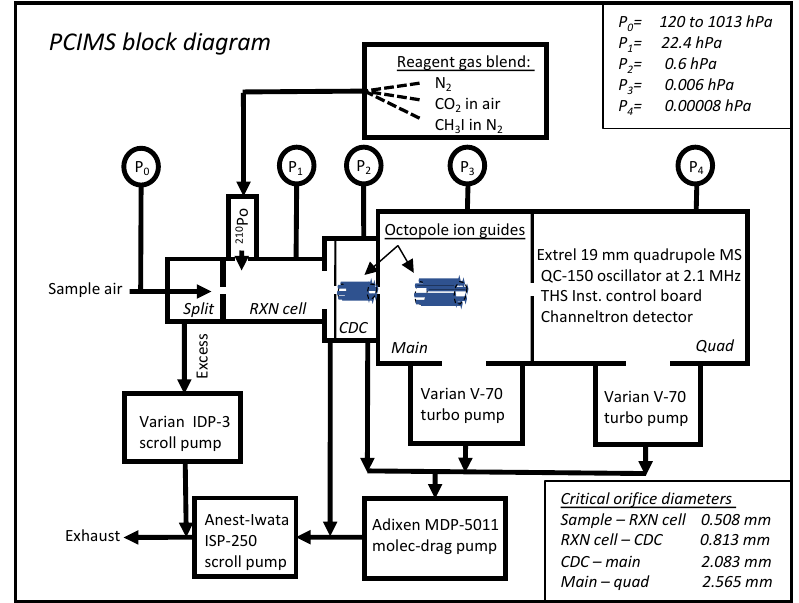
Figure A1. Block schematic of the PCIMS instrument as used on the aircraft and in the laboratory, mass flow controllers are not shown. As per Slusher et al. (2004), Le Breton et al. (2012), O’Sullivan et al. (2018) and Treadaway et al. (2018).